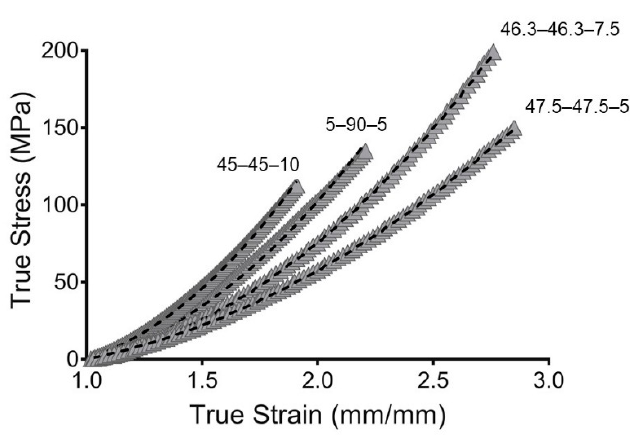
Figure 6. Hyperelastic modeling of true stress and true strain from synthesized PUs. Gray filled symbols represent the mean curve while the dashed line represents the hyperelastic model. Table 2. Hyperelastic model parameters from best regression, goodness of fitness, and reliability parameters.